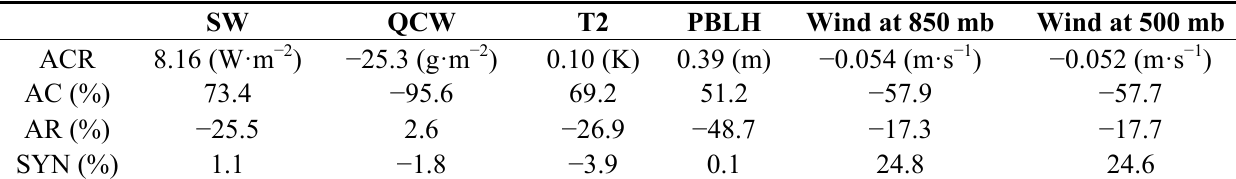
Table 3. Overall ACR effect and percentage contributions from individual factors of AC, AR, and SYN a